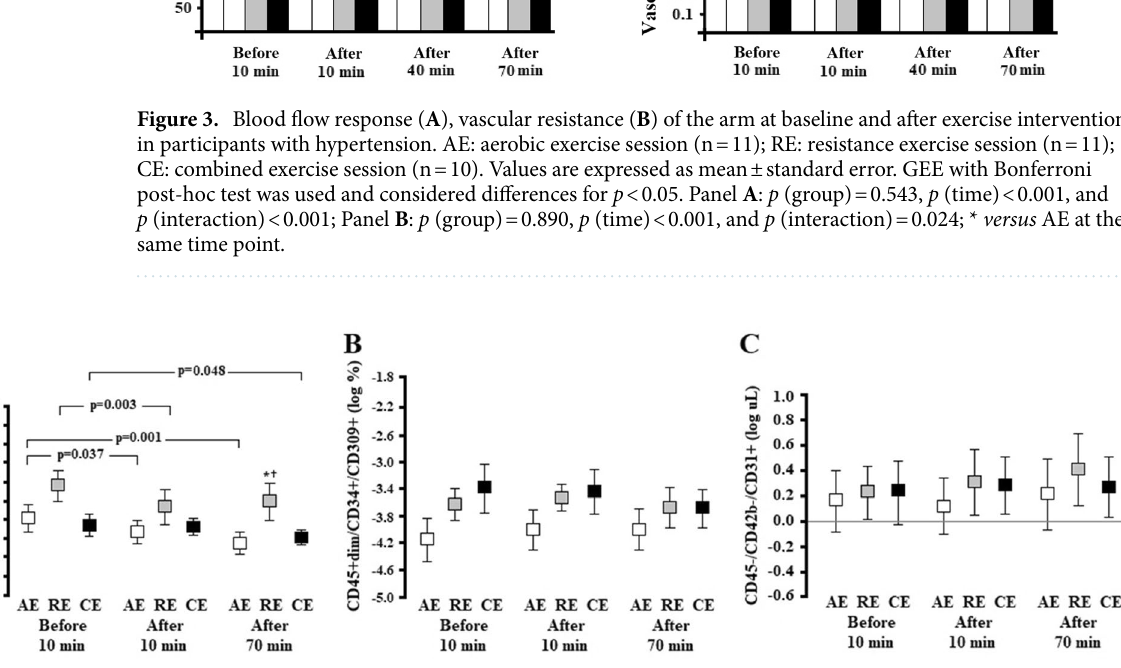
Figure 4. Response of PCs: CD45 + dim/CD34 + ( A ), EPCs—CD45 + dim/CD34+/CD309 + ( B ) and EMVs— CD45−/CD42b−/CD31 + ( C ) at baseline and after exercise interventions in participants with hypertension. AE: aerobic exercise session (n = 11); RE: resistance exercise session (n = 11); CE: combined exercise session (n = 11). Values are expressed as mean ± standard error. GEE followed by Bonferroni post-hoc test was used and considered differences for p < 0.05. Panel A : p (group) = 0.034, p (time) < 0.001, and p (interaction) = 0.025; Panel B : p (group) = 0.033, p (time) = 0.186, and p (interaction) = 0.111; Panel C : p (group) = 0.638, p (time) = 0.149, and p (interaction) = 0.840; * versus AE at the same time point; † versus CE at the same time